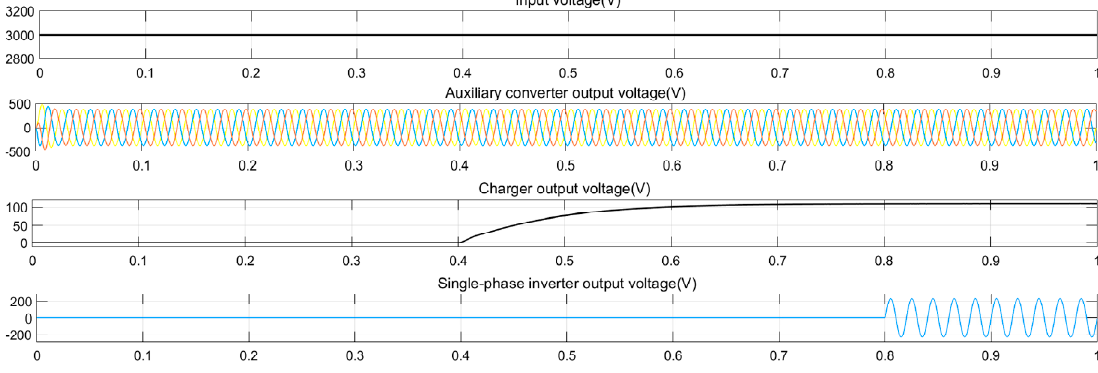
Figure 14. Power supply system step-by-step simulation results.